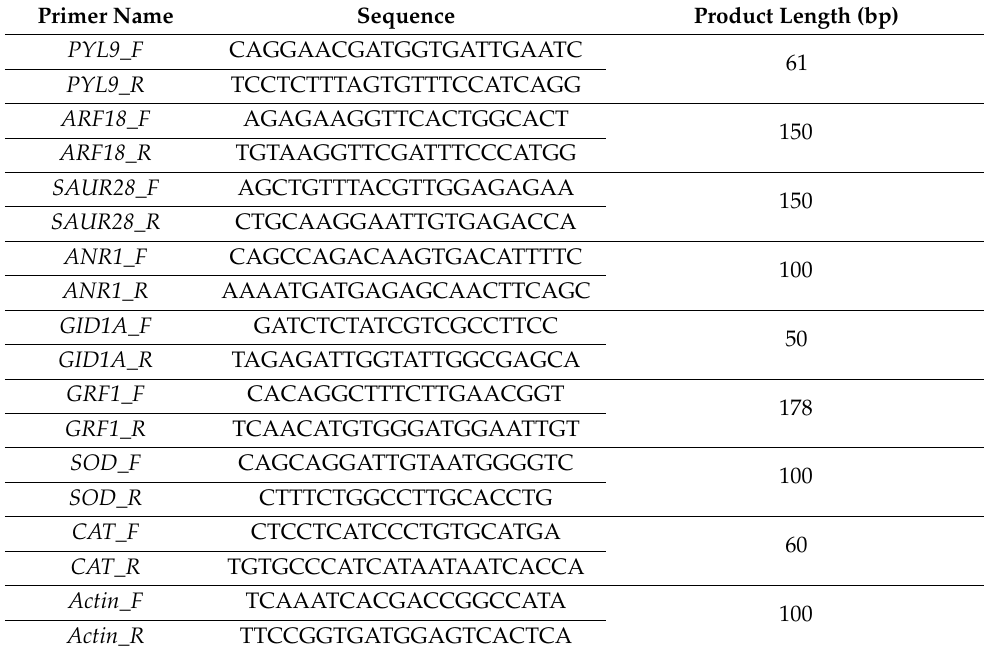
Table 1. The list of primers used in the present